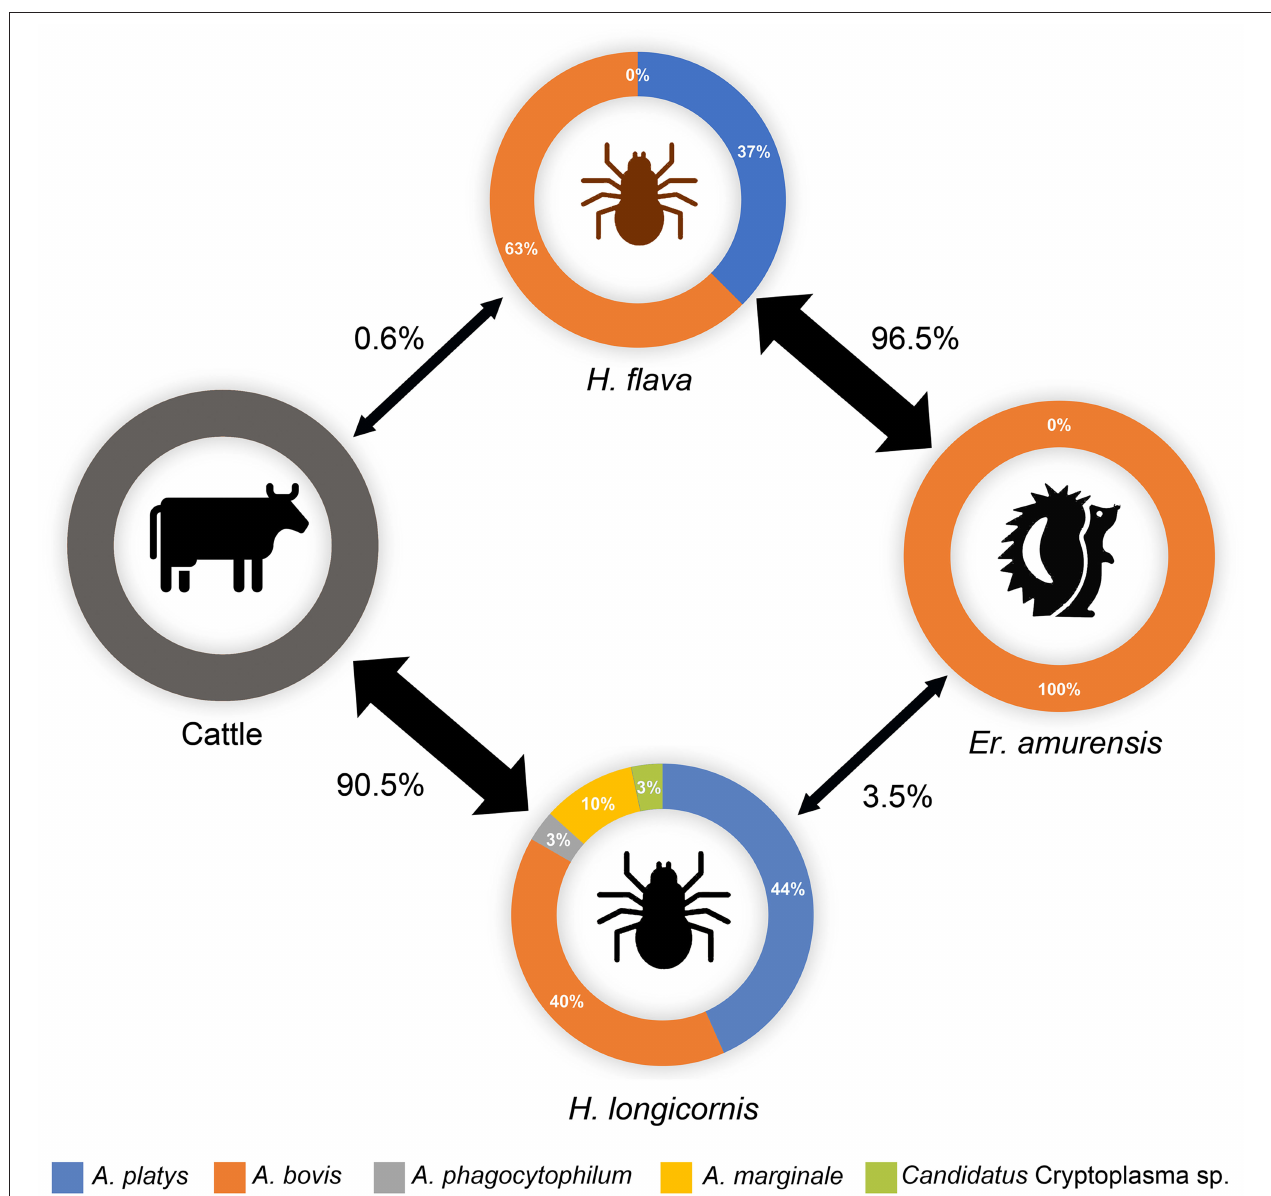
FIGURE 3 | Potential transmission circle of Anaplasma spp. in ticks and animals in the investigated area. The thickness of the arrow represents the parasitic rates (number of ticks of specific species/number of total parasitic ticks) of each tick species on hedgehog or cattle hosts, which are also indicated beside the arrows. The relative abundances of each Anaplasma spp. in positive samples are indicated. Data on cattle were not